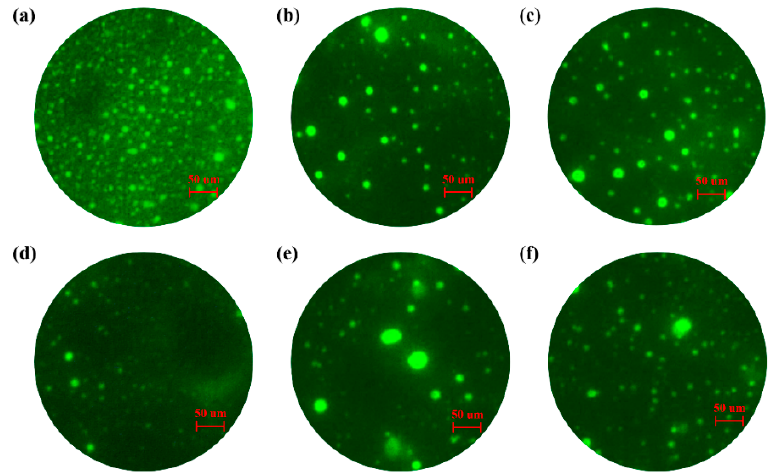
Figure 3. The fluorescence microscope images of the top parts ( a – c ) and bottom parts ( d – f ) of SMB, LSMB and OLSMB.